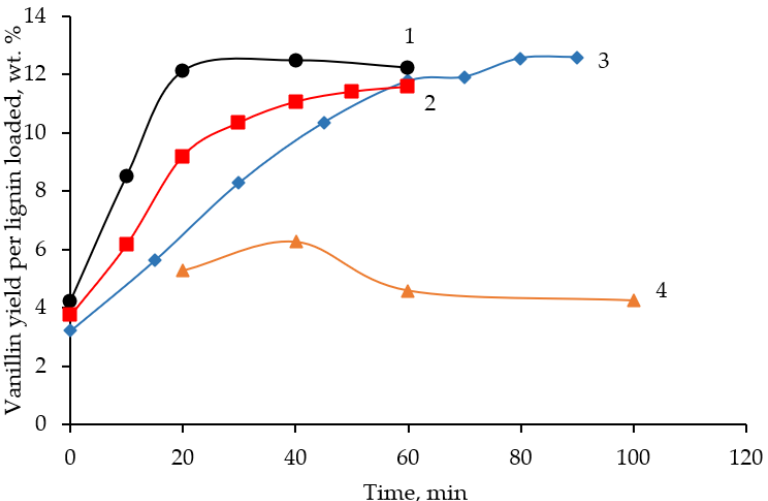
Figure 4. Influence of the catalyst on the vanillin formation and yields. 1—O 2 , CuO, 5% NaOH; 2—O 2 , CuO, 3.75% NaOH; 3—O 2 , 3.75% NaOH; 4—CuO, 3.75% Table 1. Influence of the catalyst on the vanillin yield and the reagent consumption. Reagents